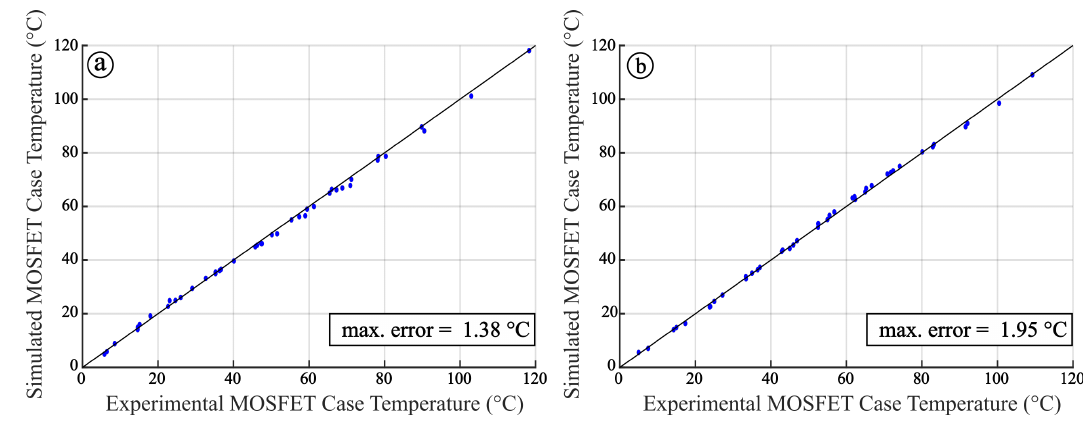
Figure 10. The experimental and the simulated steady-state MOSFET case temperature of the ( a ) cascode GaN MOSFET and the ( b ) SiC MOSFET when loaded by the same input